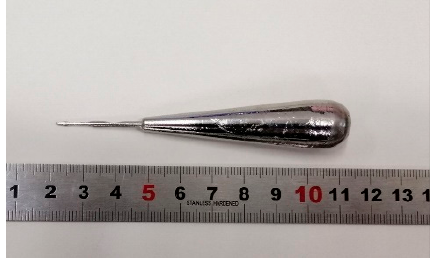
Materials 2019 , 12 , x FOR PEER REVIEW Figure 1. An as-cast conical sample for determining the critical diameter of different alloy compositions.